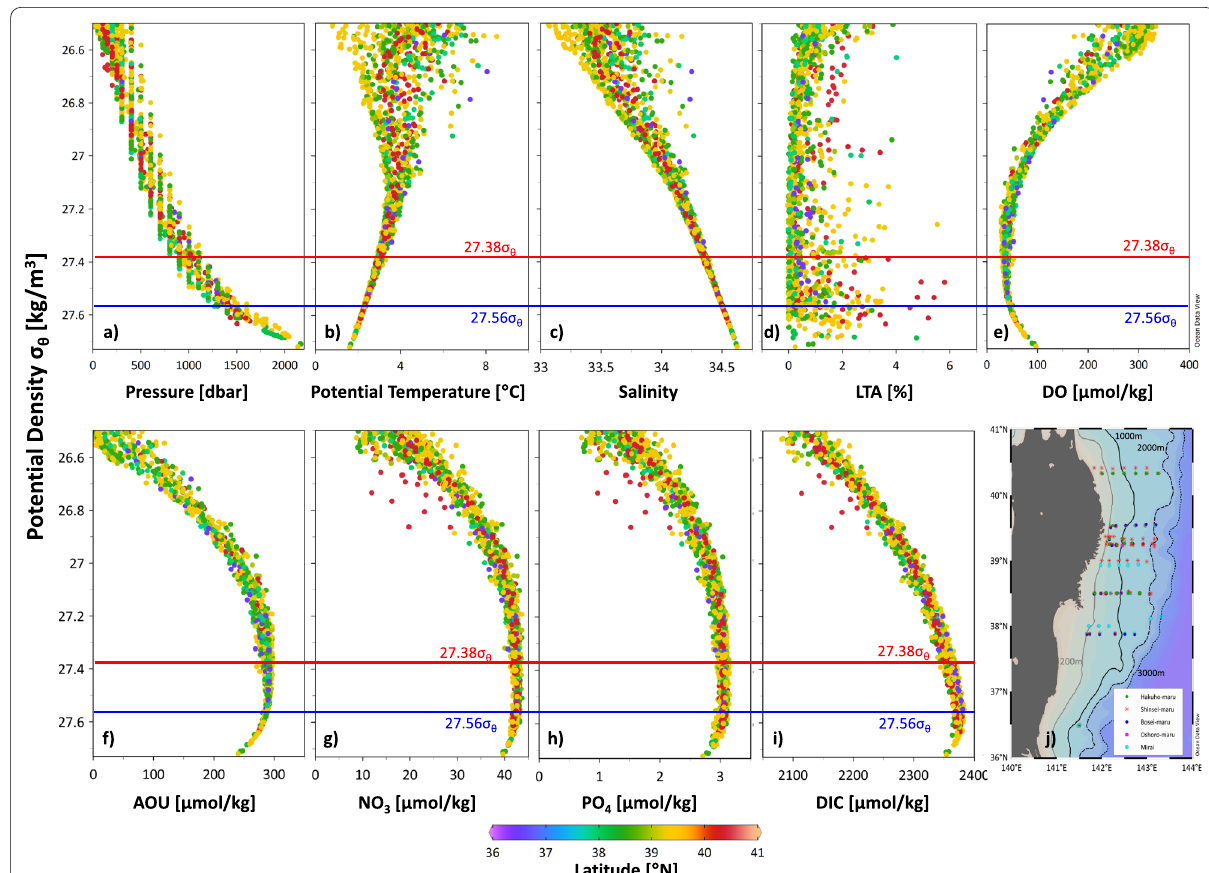
Fig. 4 Vertical profiles of pressure ( a ), potential temperature ( b ), salinity ( c ), LTA ( d ), DO ( e ), AOU ( f ), NO 3 ( g ), PO 4 ( h ), and DIC ( i ) as functions of potential density (σ θ ) and the location map ( j ) by using the cruises (Table 1). Colored circles denote the latitude of sampling locations. Lines show the studied isopycnal surfaces (27.38σ θ : red; 27.56σ θ :